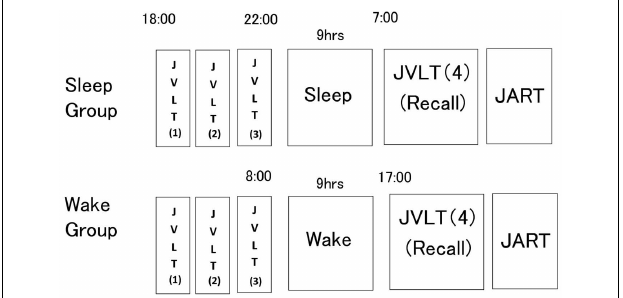
FIGURE 2 | Experimental procedure .The sleep group received a learning session by means of three consecutive administrations of the Japanese Verbal LearningTest (JVLT) before initiation of sleep. On the morning of the following day, subjects were asked to recall as many words as possible without presentation of words.The wake group underwent the same examination procedure, as described in the figure